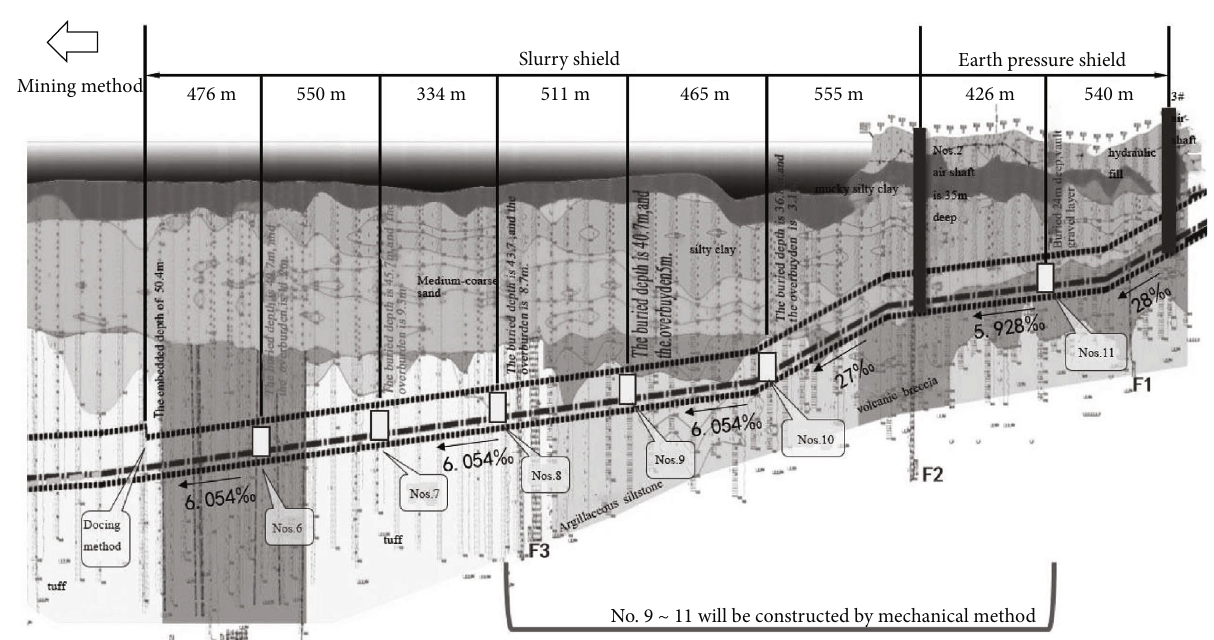
Figure 4: Geological pro fi le of the location of the connecting aisle.